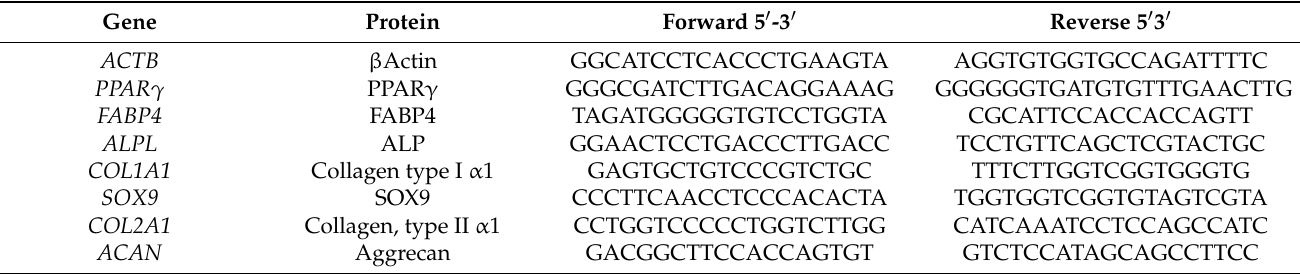
Table 2. Primers used in qPCR